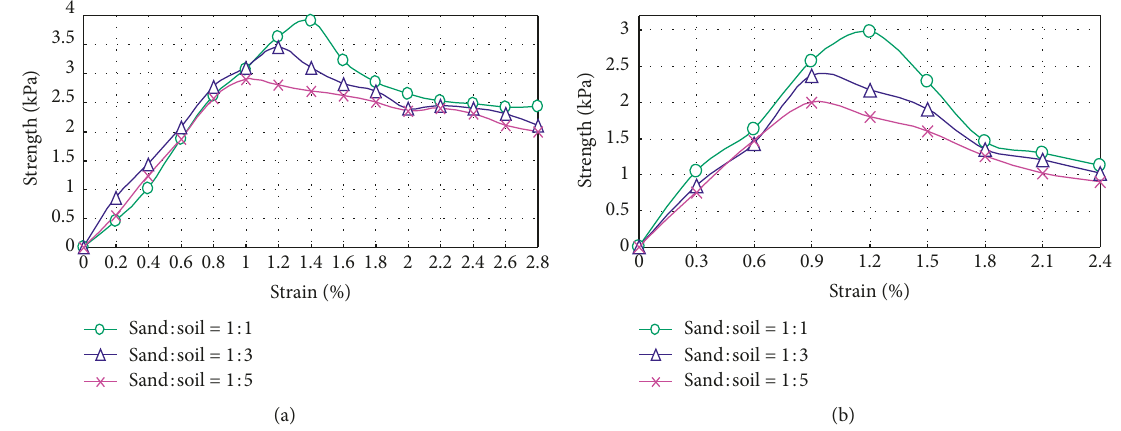
Figure 2: Stress-strain curve in various ratios between sand and soil. (a) Gelatinizing agent ratio 10:1. (b) gelatinizing agent ratio